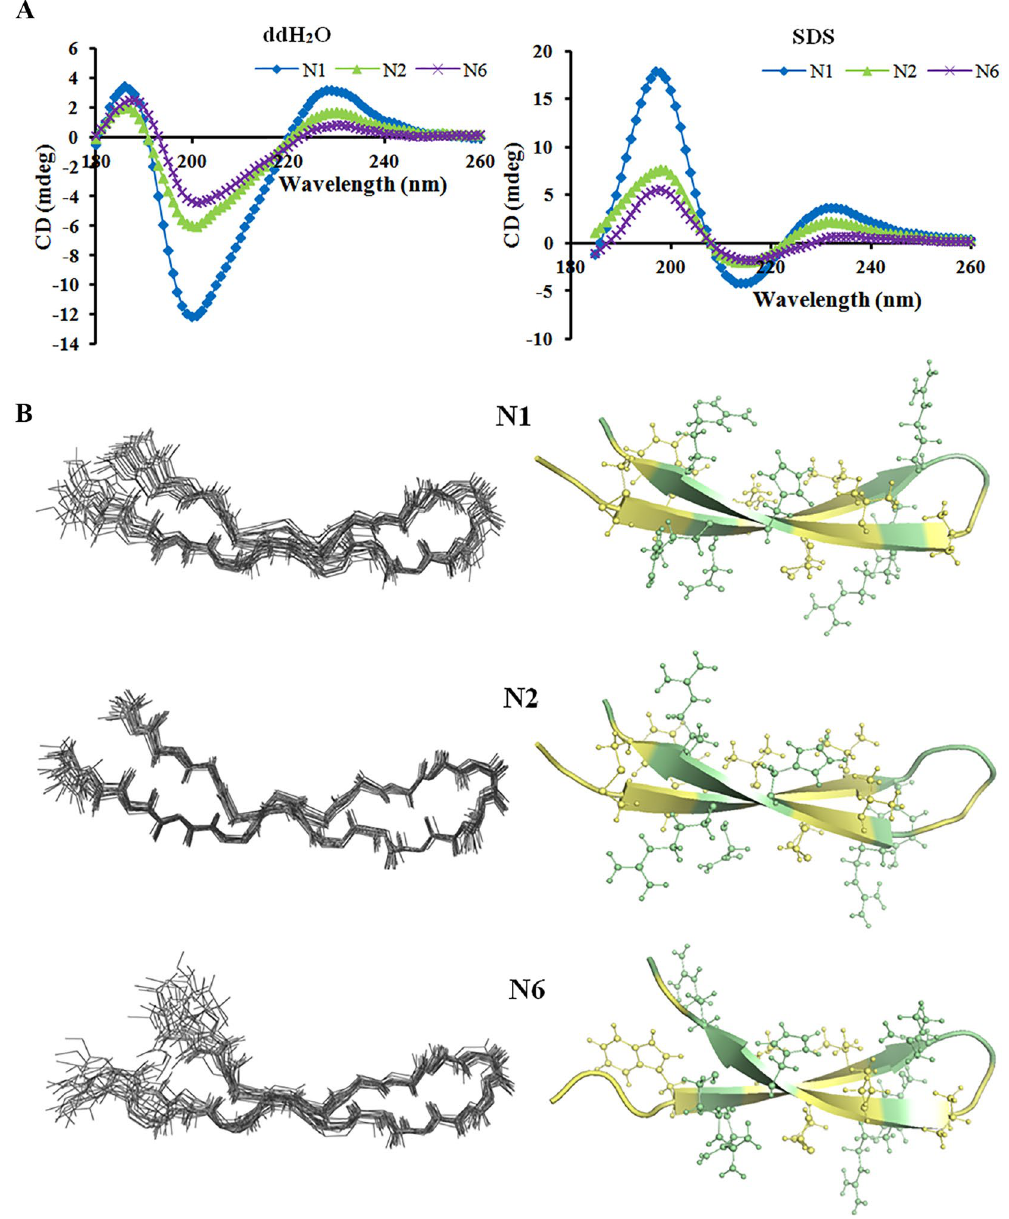
Figure 2. Structures of N1, N2, and N6. ( A ) CD spectra of N1, N2 and N6. ( B ) NMR analysis of N1, N2 and N6. Left panel shows the sets of the 20-best structures, superimposed over the backbone atoms. Only backbone atoms are shown. Right panel shows the ribbon representations of the peptides. The side chains on the β -sheet strands are represented by balls and sticks. The hydrophobicity and hydrophilicity of the residues are color- coded pale yellow and pale-green, respectively. The figure was prepared using the program